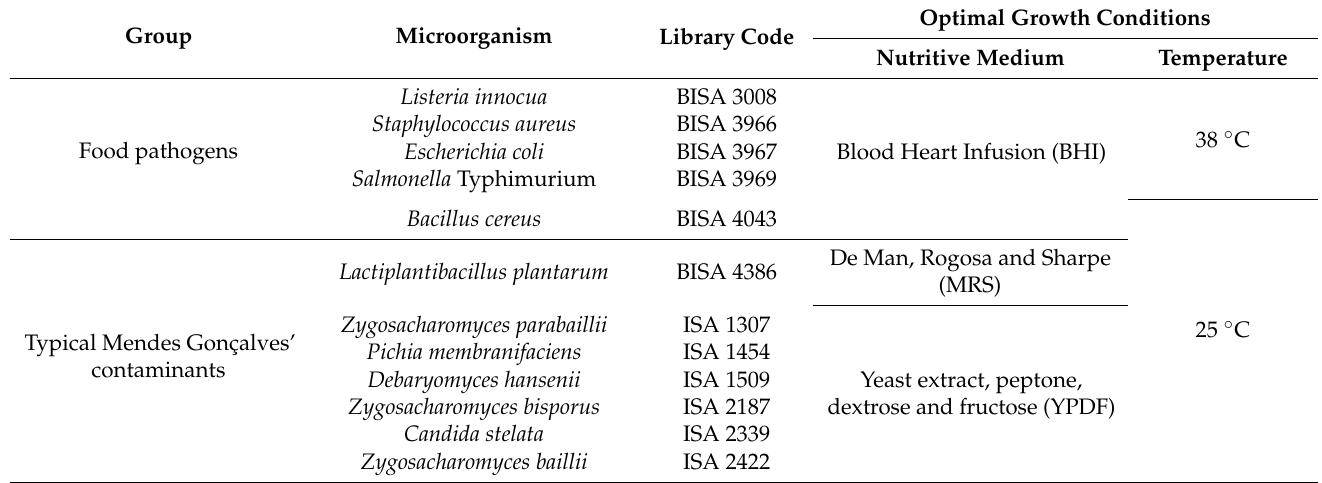
Table 1. Food pathogens and contaminant microorganisms used to test antimicrobial activity of grass pea sweet miso by drop